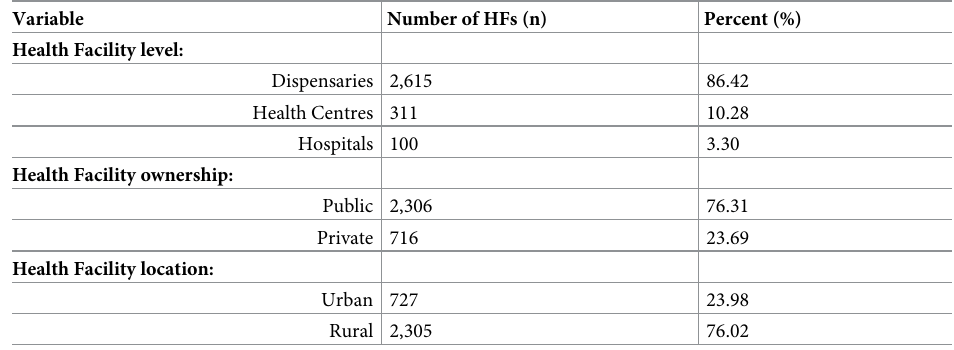
Table 2. Characteristics of health facilities involved in the study (N = 3,032).